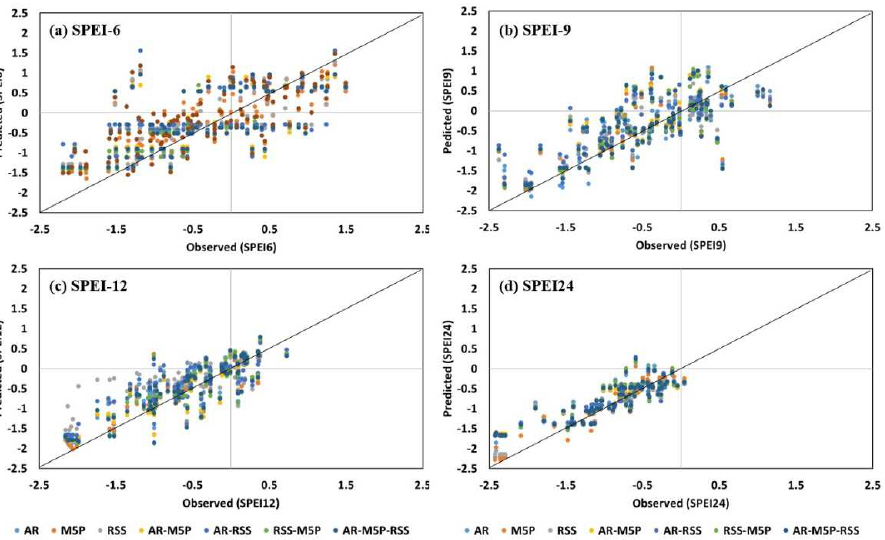
Figure 5. The scatter plots depict the observed and predicted SPEI values for various models at Rajshahi station over multiple time scales during the testing period, ( a ) SPEI-6, ( b ) SPEI-9, ( c ) SPEI-12, ( d ) SPEI-24.